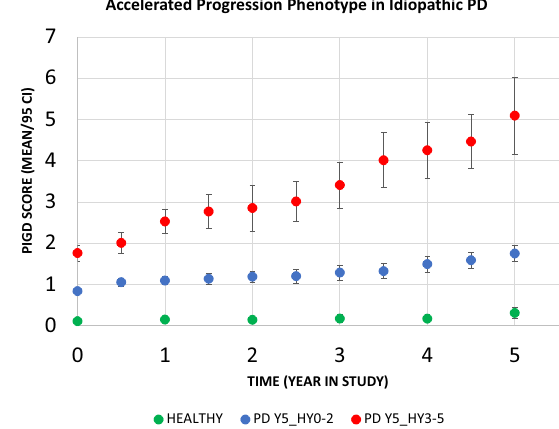
Fig. 1 Individuals who had at least one rating of HY 3, on medication, within the fi rst 5 years of PPMI follow up (red circles) were characterized by signi fi cantly more rapid progression of gait dysfunction as measured by the PIGD scale compared to individuals who maintained HY status of 2 or less during the fi rst 5 years of treatment (blue circles). Controls (green) are presented as a